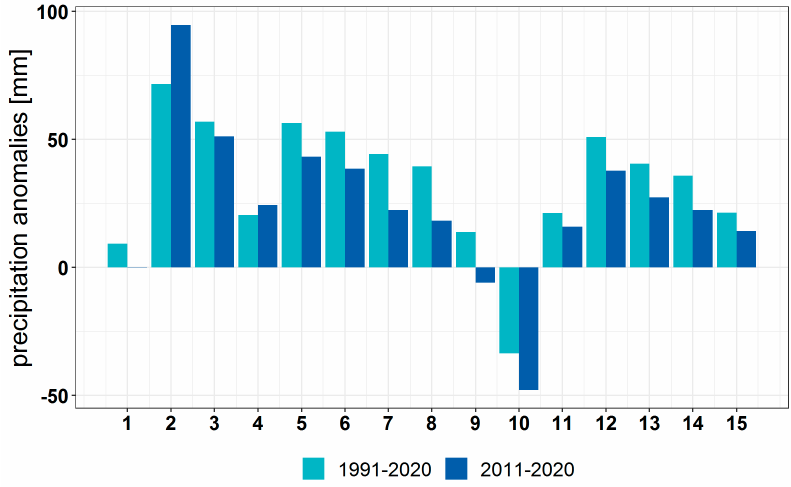
Figure 15. The differences in AP VS over the last 30 years compared to 1951–1960 decade for the main forest types.